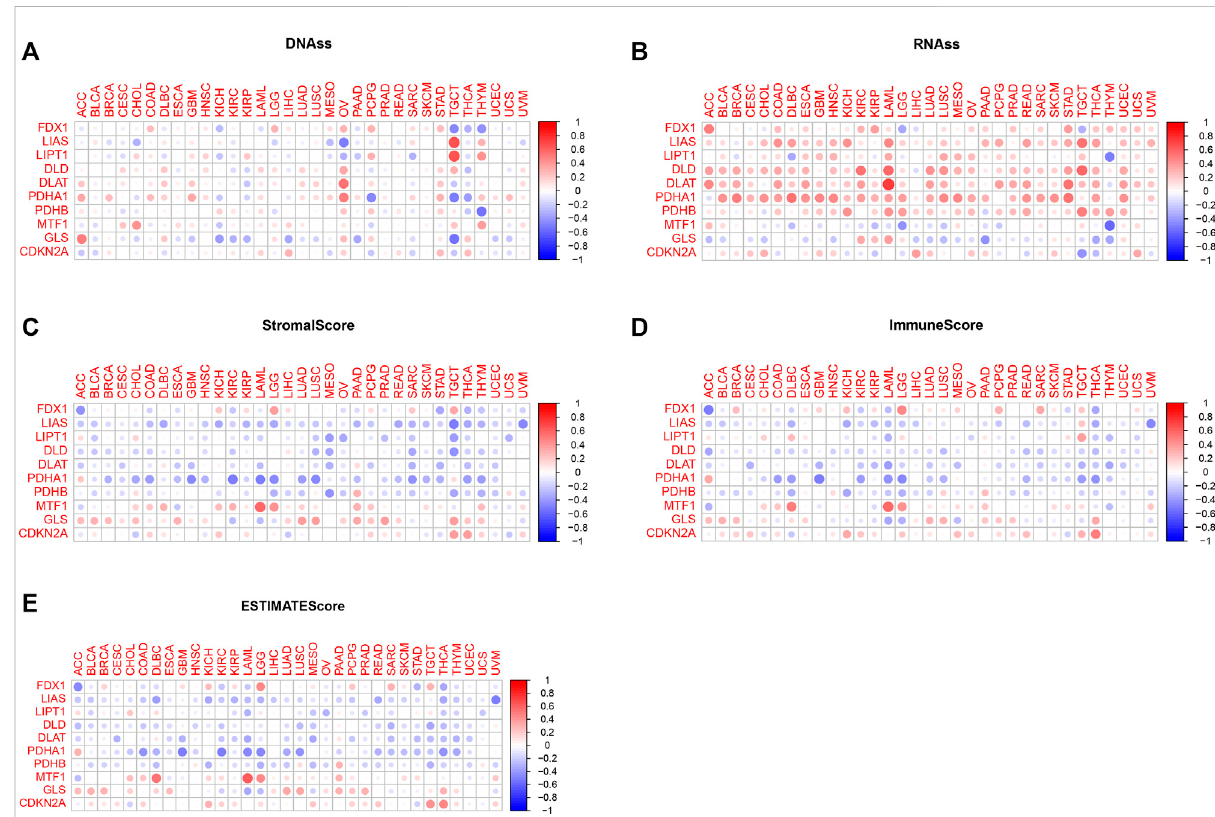
FIGURE 7 Correlation analysis ofcuproptosis-associatedgeneswithtumorstemcellsandthetumormicroenvironment. (A) Correlation analysis between cuproptosis-associated gene expression and stemness scores based on DNA methylation. (B) Correlation analysis between cuproptosis-associated geneexpressionandstemnessscoresbasedonRNAexpression. (C – E) Therelationshipsamongtheexpressionofcuproptosis-associatedgenesand stromal scores, immune scores, and ESTIMATE